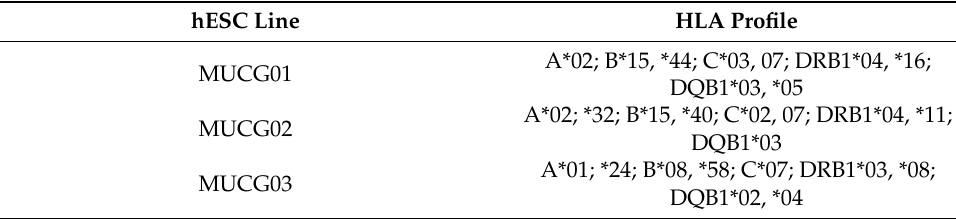
Table 6. HLA profile of the hESC lines MUCG01, MUCG02, and MUCG03. hESC